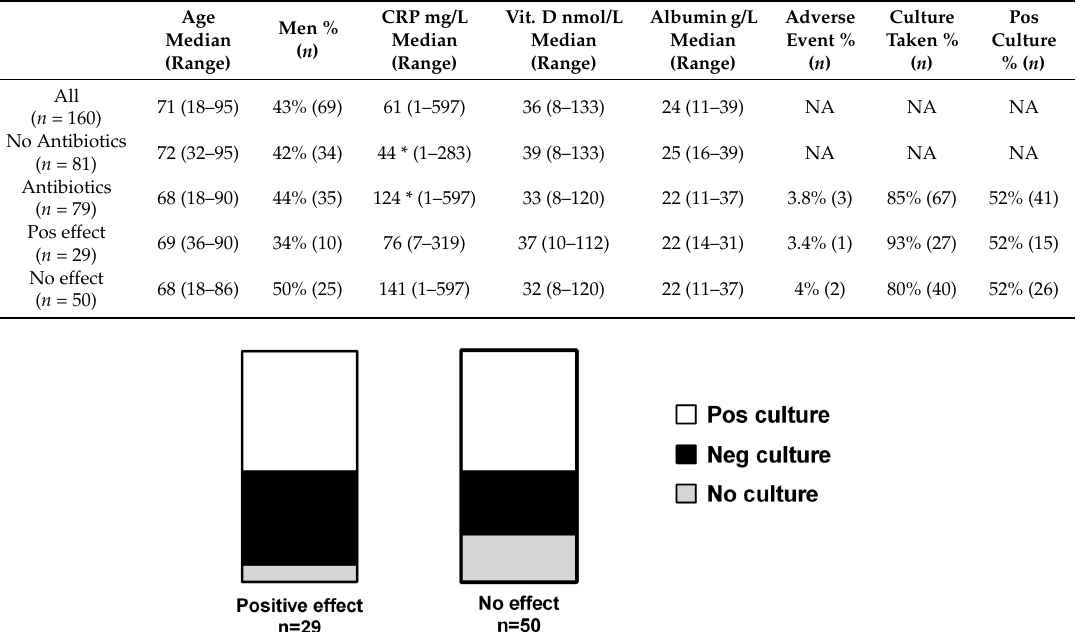
Table 1. Demographic data of the study cohort of 160 end-of-life cancer patients. Effect of antibiotic treatment; positive effect (Pos effect) or unknown/no effect (No effect); is presented. Reference range according to Clinical Chemistry Dept. of Karolinska University Hospital: CRP <3 mg/L, Vit. D 75–250 nmol/L, Albumin 36–48 nmol/L. * CRP-levels among the antibiotic treated patients were significantly